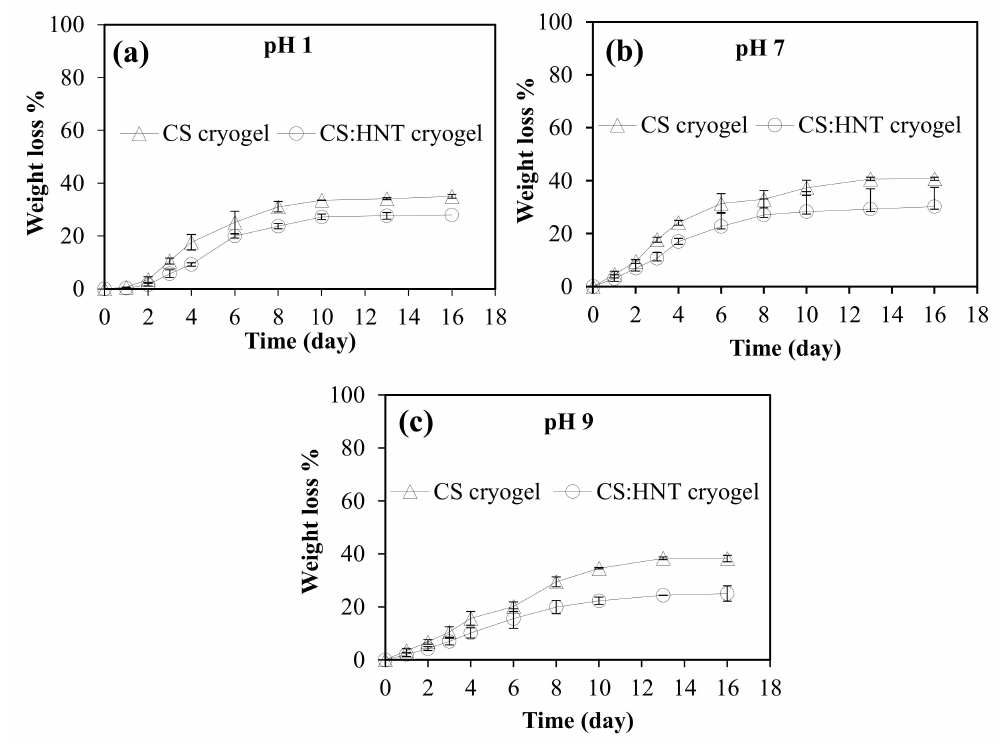
Figure 4. Hydrolytic degradation of CS cryogel and CS:HNT cryogels at pH ( a ) 1, ( b ) 7.4 and ( c )